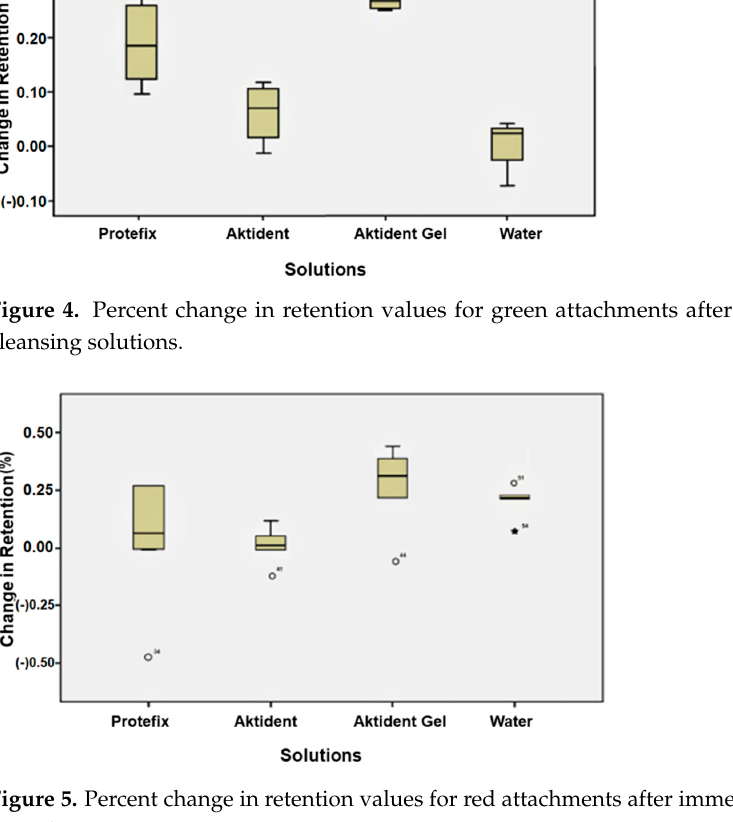
Figure 5. Percent change in retention values for red attachments after immersion in different cleansing solutions .